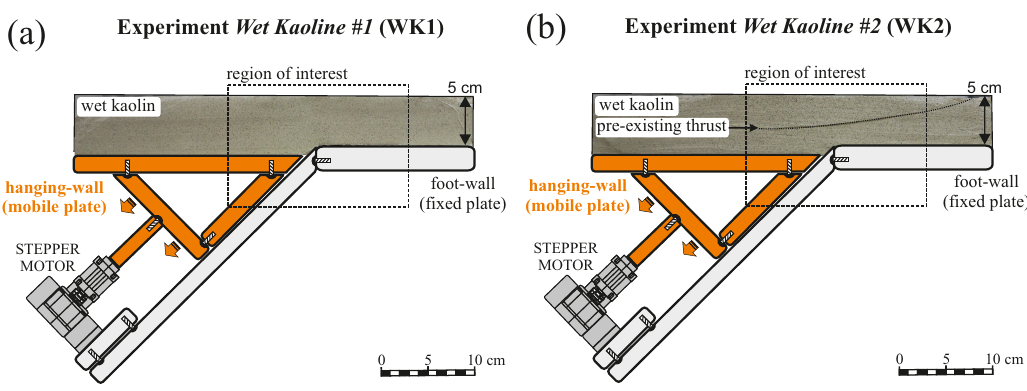
Figure 6. Experimental setup used to model (a) a fault evolving into a medium configuration and (b) with a low-angle discontinuity.